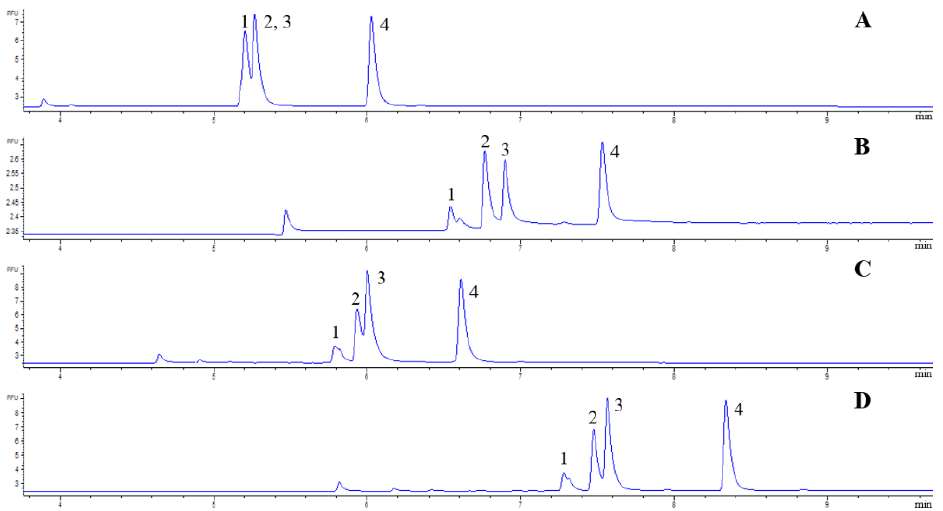
Figure 2. The CZE separations of a mixture of four carbohydrates using LEDIF detection. Conditions: fused silica capillary, l tot : 65 cm × 50 µm id, l eff : 45 cm, BGE: ( A ) 25 mM ammonium acetate (pH 4.5), ( B ) 25 mM ammonium acetate-0.3% PEO (pH 4.5), ( C ) 40 mM EACA (pH 4.5), ( D ) 40 mM EACA-0.02% HPMC (pH 4.5), separation voltage: −30 kV, injection: 50 mbar × 2 s, preconditioning: 1 M HCl for 5 min, BGE for 5 min washing. LEDIF detection was performed at 480 nm excitation/520 nm emission. Sample: 1: fructose, 2: glucose, 3: mannose, 4: